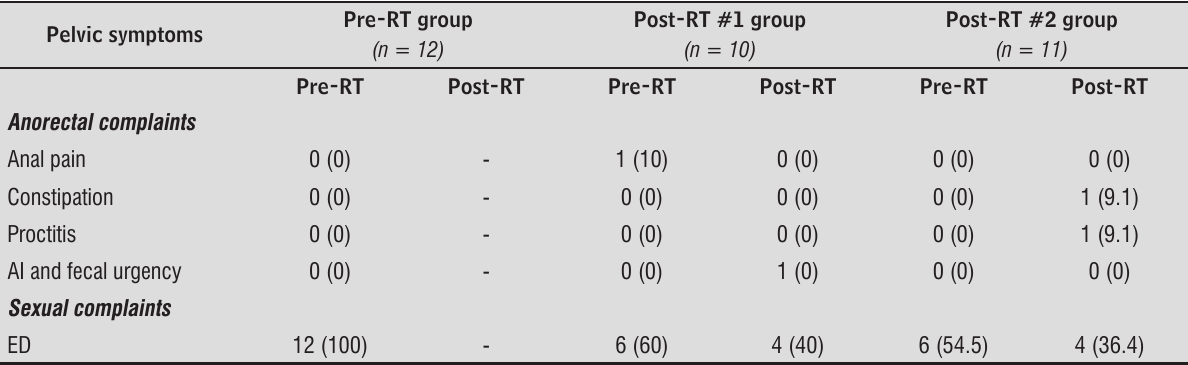
Table 3 - Pre- and post-radiotherapy pelvic symptoms [ n ( % ) ] Pelvic symptoms